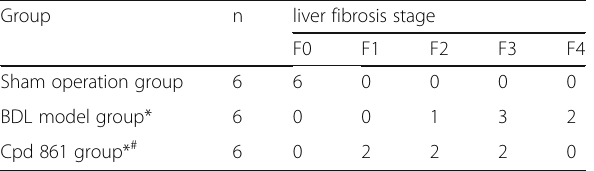
Table 2 Liver fibrosis stage using the METAVIR system Group